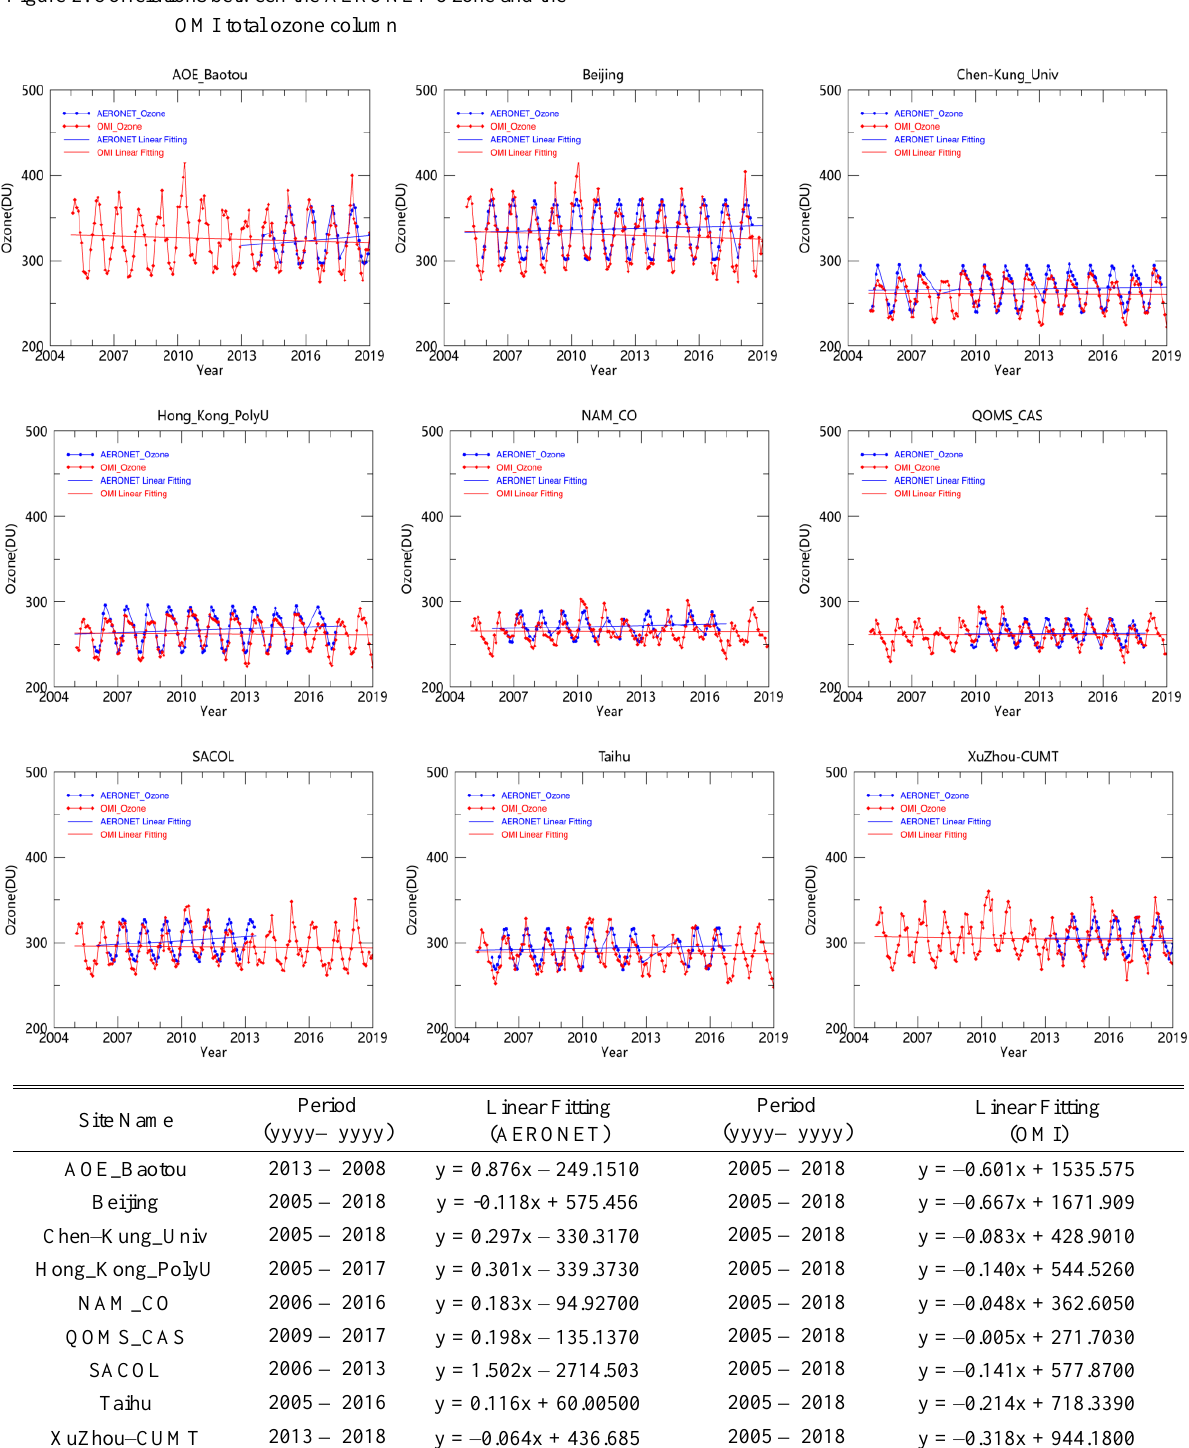
Figure 2. Correlations between the AERONET Ozone and the